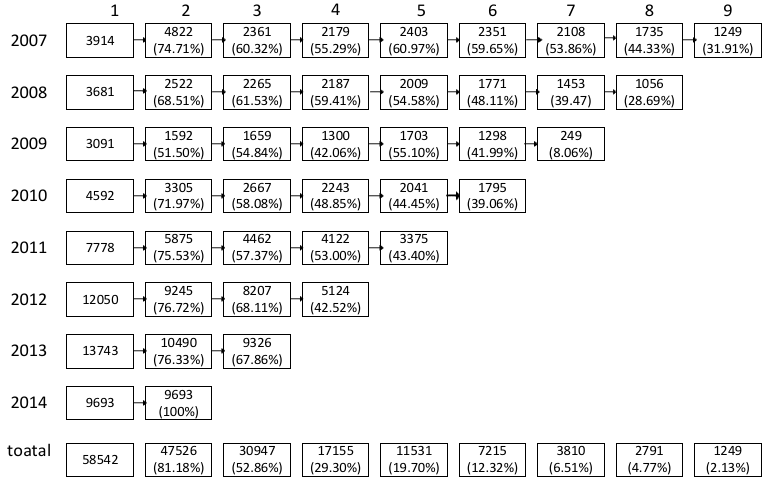
Figure 1. The samples of repeated surveys at each year.